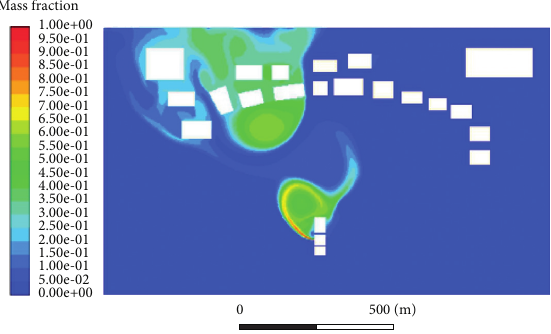
Figure 6: Radionuclide dispersion at the western break.